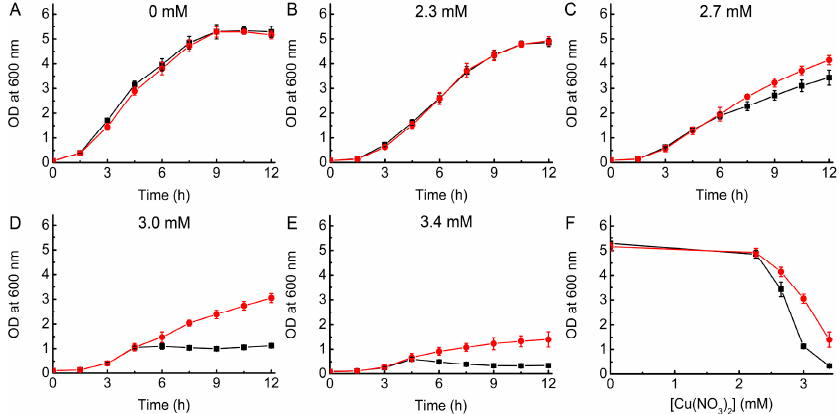
Figure 5. The influence of Mt Csp3 overexpression on the growth of WT E. coli in Cu. Growth (37 ◦ C) of WT E. coli plus pBAD33_ Mtcsp3 (red circles) and pBAD33 (black squares) in LB media plus 0.2% l -arabinose in the presence of 0 ( A ), 2.3 ( B ), 2.7 ( C ), 3.0 ( D ), and 3.4 ( E ) mM Cu(NO 3 ) 2 . A comparison of growth after 12 h is given in ( F ). Average OD values and standard deviations from three independent experiments are shown.